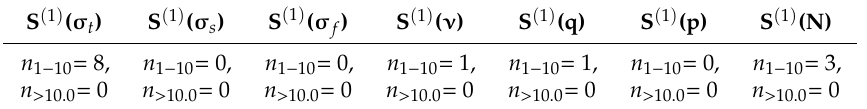
Table 7. Summary of the large 1st-order relative sensitivities for the PERP benchmark.